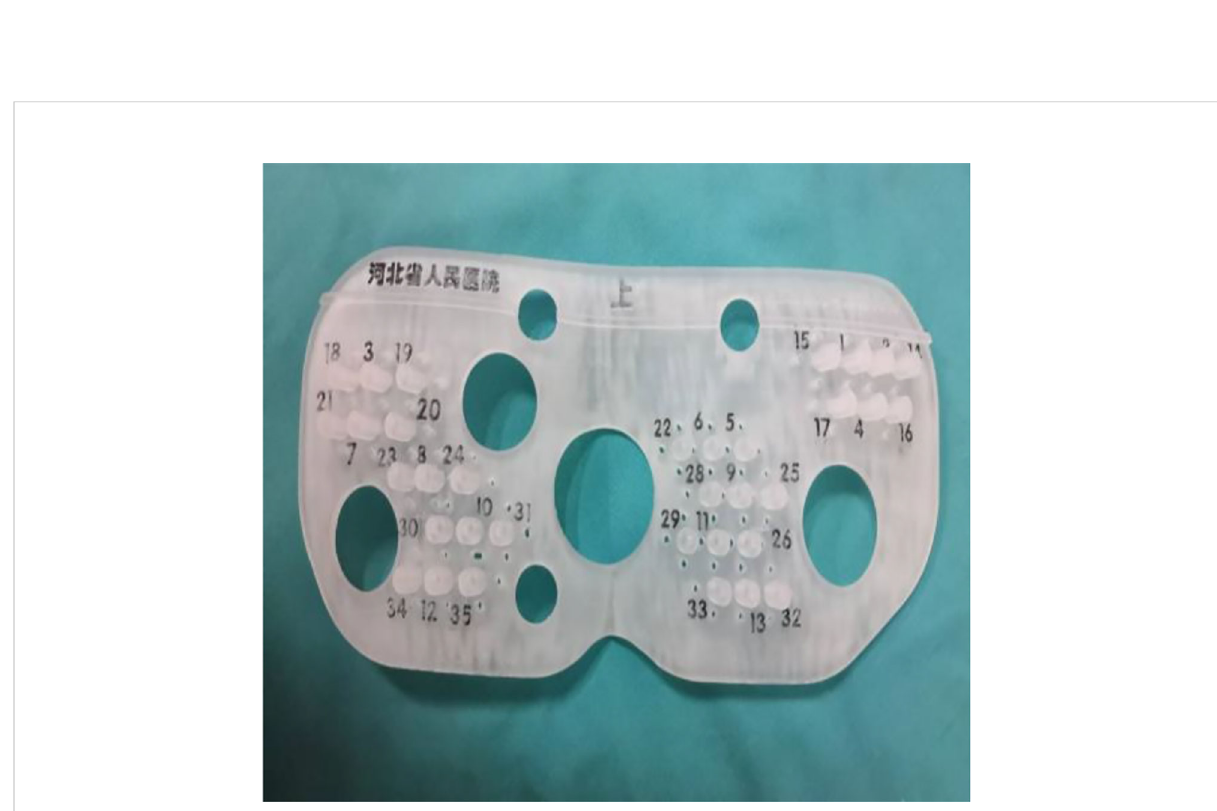
FIGURE 2 Design and print of an individualized 3D template according to the preoperative plan.